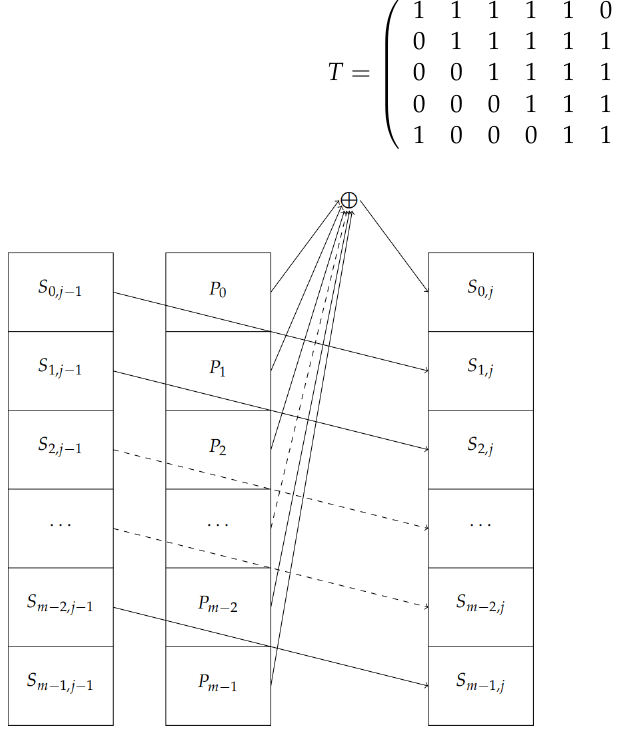
Figure 2. LFSR-based Toeplitz matrix generation process.